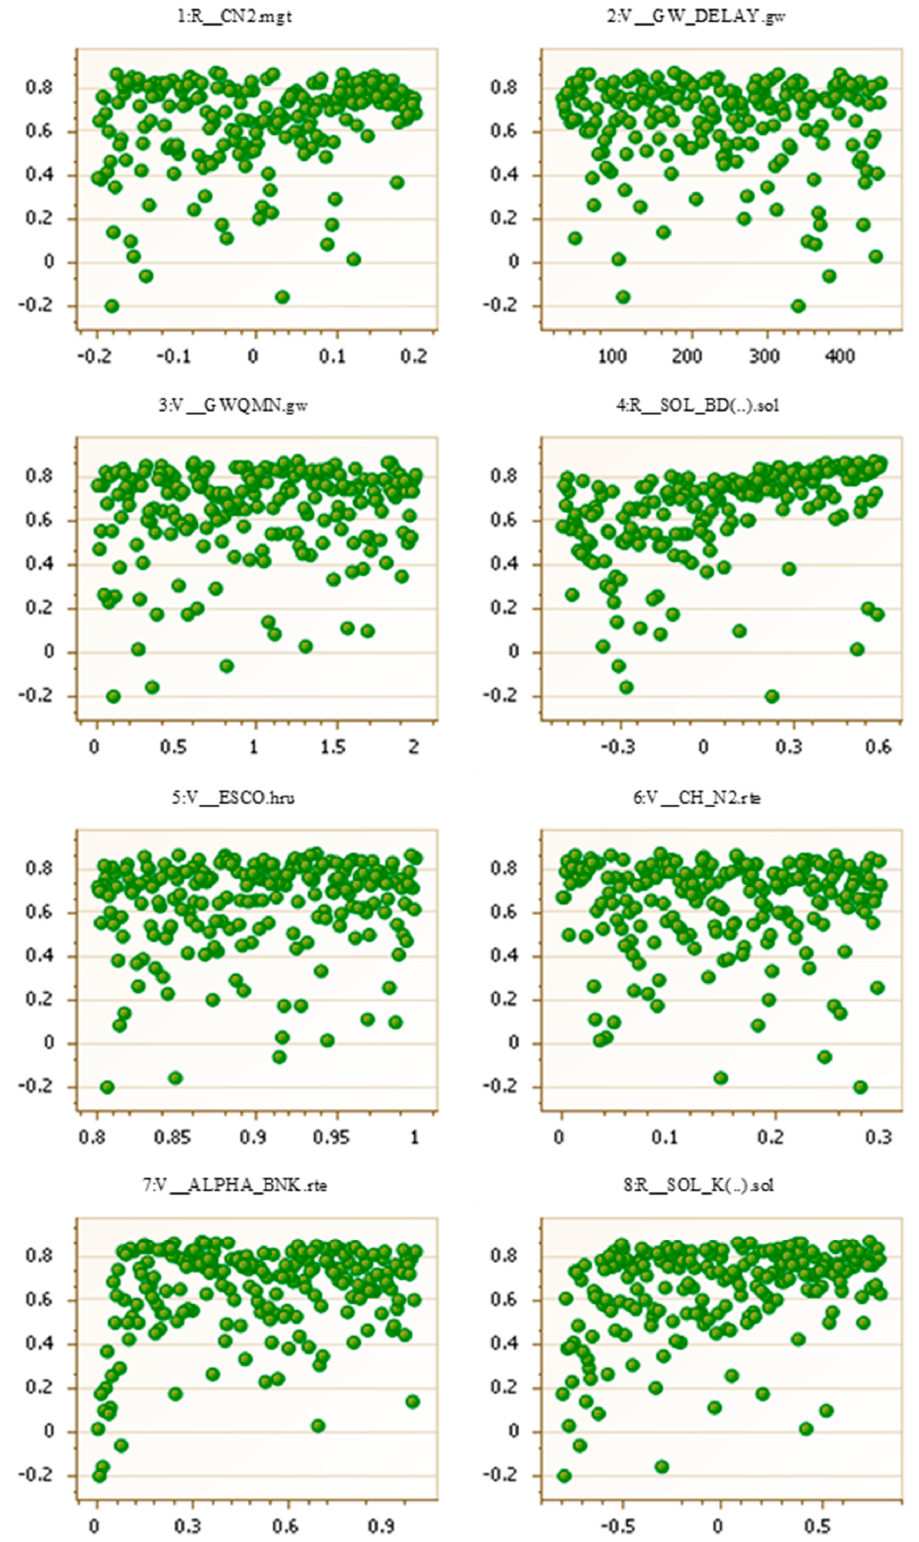
Figure 9. Objective function NSE versus sensitive parameters showing the sensitivity of model parameters for